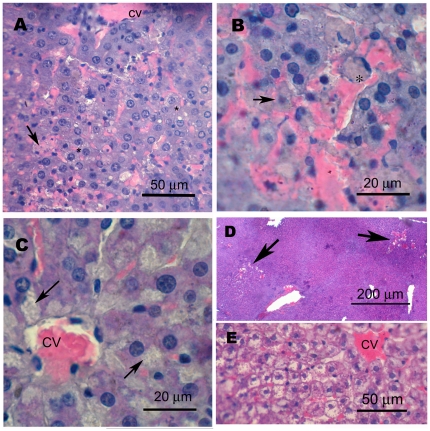
Pathology of livers from rats treated 48 h earlier with 50 mg/kg 2,6DNT (A,B) or 384 mg/kg TNT (C).Photomicrographs are from 5 µm sections stained with hematoxylin and eosin. Livers from one of 5 rats treated with 50 mg/kg 2,6DNT exhibited sloughing of hepatocyte remnants into congested sinusoids (A, arrow) and microvesiculated hepatocytes (A, *). A necrotic hepatocyte with pyknotic nucleus displaced from the liver cord by infiltrating erythrocytes is shown in B (arrow). Numerous apoptotic cells (B, *) were also seen. Amorphous vacuoles occupying a considerable portion of hepatocyte cytoplasms were numerous in livers of 3 of 5 rats treated with 384 mg/kg TNT (C, arrows). One rat treated with 94 mg/kg 4ADNT had focal hemorrhagic areas in the liver (D, arrows), while livers of other rats treated with 94 and 197 mg/kg 4ADNT exhibited ballooning degeneration (E).